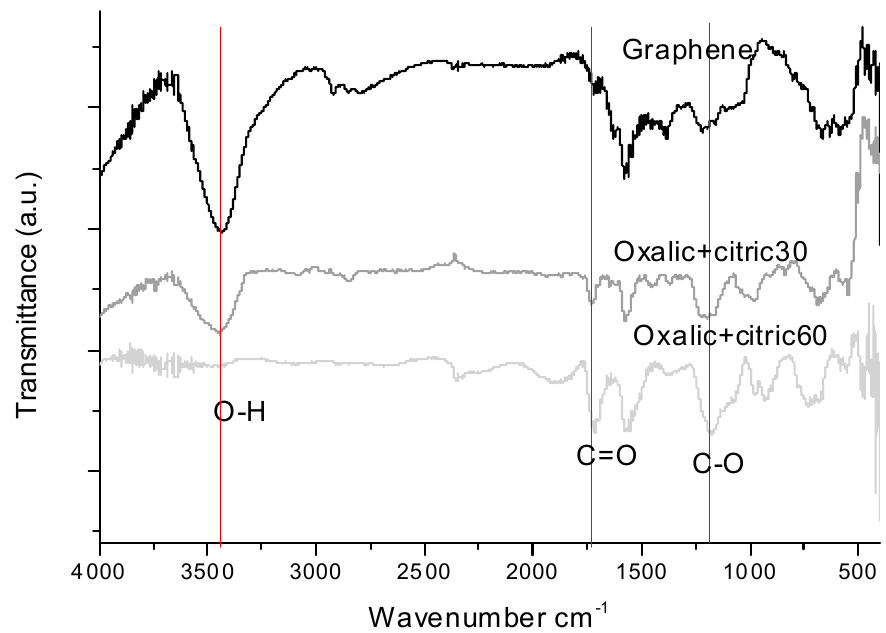
Figure 1. Fourier transform infrared (FT–IR) spectra of the unmodified and modified graphene with Oxalic+Citric30 and Oxalic+Citric60.